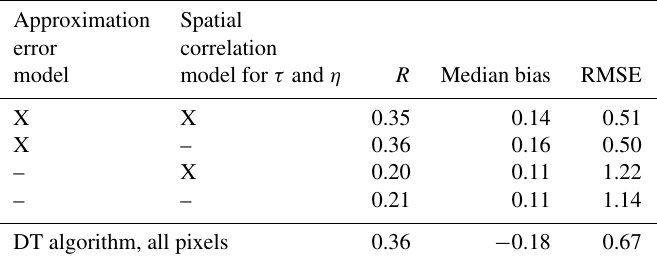
Table 3. Global statistics of Ångström exponent retrievals for Bayesian aerosol retrieval (BAR) run with different models. The models considered are the approximation error model and the spatial correlation model for AOD and FMF. X and – in the table indicate that the corresponding model was and was not included in the retrieval, respectively. Only results with AERONET AOD ≥ 0.2 were used in the MODIS–AERONET comparison. All pixels were considered in the retrieval and each row correspond to data from 302 AERONET stations and 10354 collocated